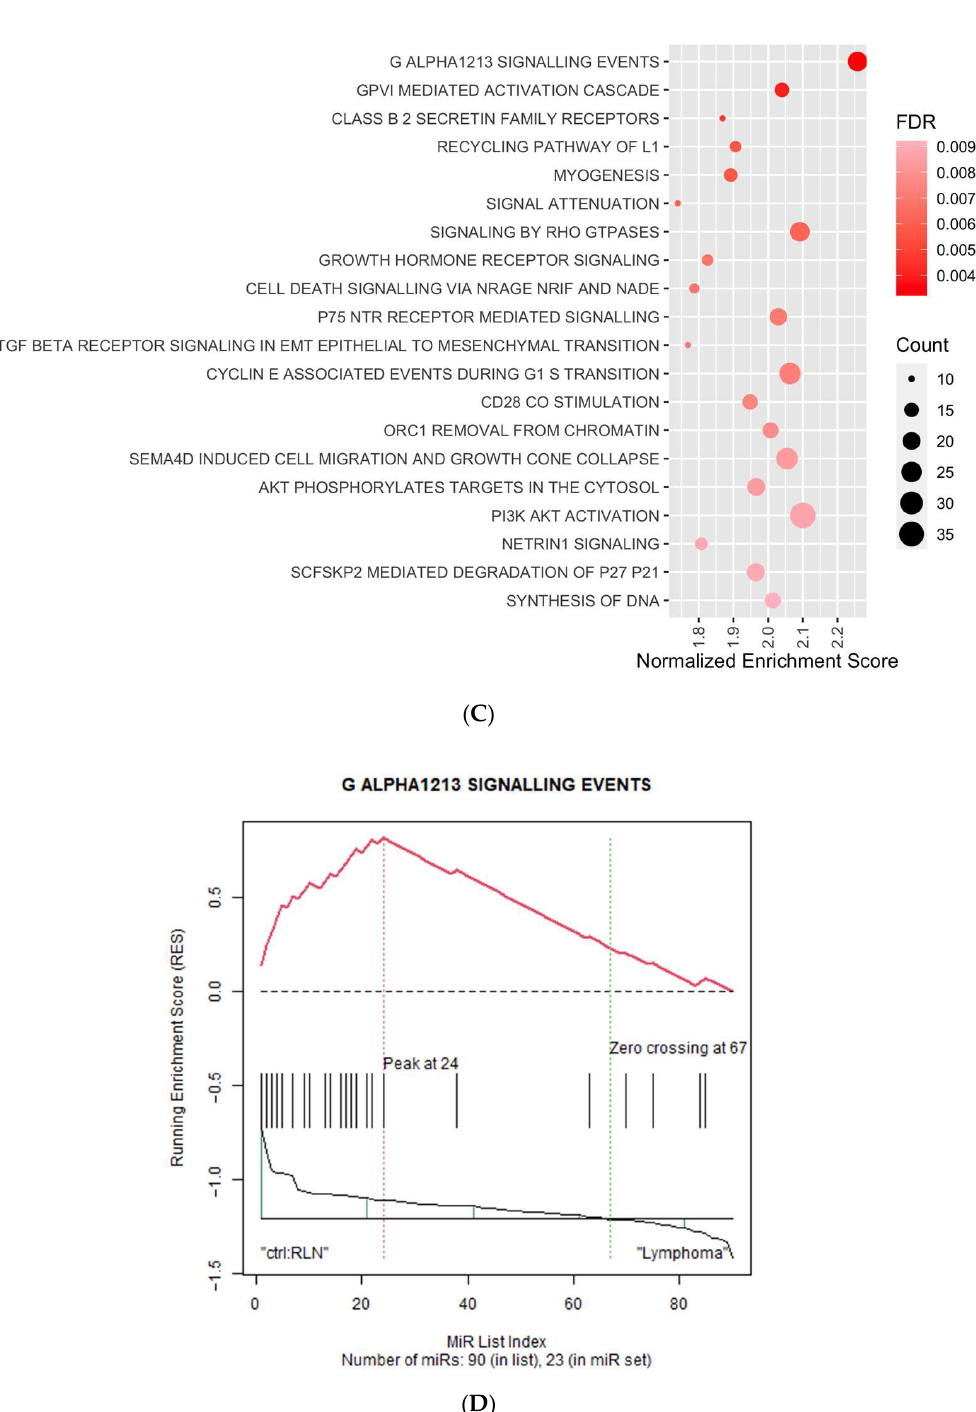
Figure 5. Differentially regulated pathways between lymphomas and reactive lymphoid proliferation based on deregulated miRNAs using MiRSEA analysis. ( A ) KEGG pathways significantly up-regulated in lymphoma compared to reactive lymphoid proliferation via miRNA regulation. ( B ) Cytosolic DNA sensing pathway as the most significantly enriched KEGG pathway for miRNAs de-regulated between lymphoma and RL groups. ( C ) Reactome pathways are significantly up-regulated in lymphoma compared to RL via miRNA deregulation. ( D ) G ɑ 12/13 signaling events as the most significantly enriched reactome pathway for miRNAs de-regulated between lymphoma and RL groups. Abbreviations: KEGG, Kyoto encyclopedia of genes and genomes; FDR, false discovery rate.